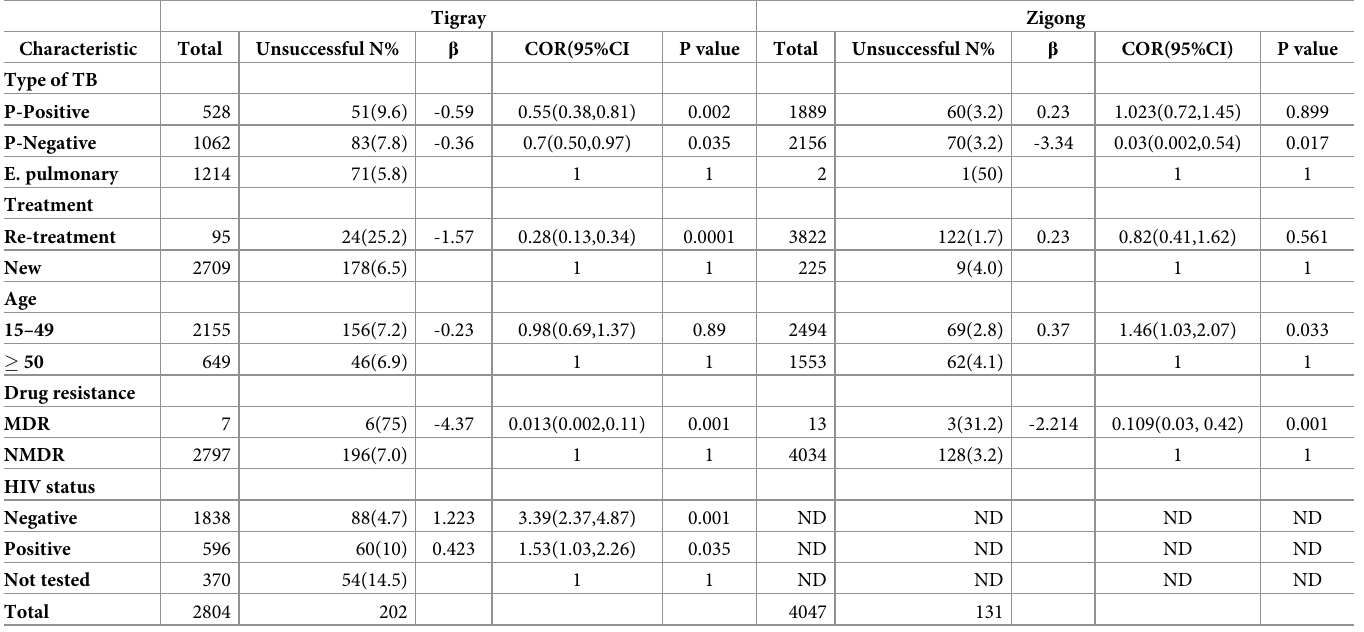
Table 3. MLR factors associated with treatment outcome of women in Tigray and Zigong January 2007 December 2016 N = 2084 and N = 4047. Tigray Zigong Characteristic